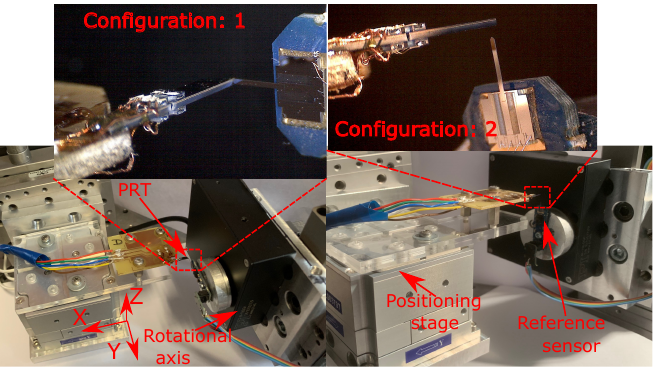
Figure 10. Experimental setup for device characterization (configuration: 1 for the Y axis; configura- tion: 2 for the Z